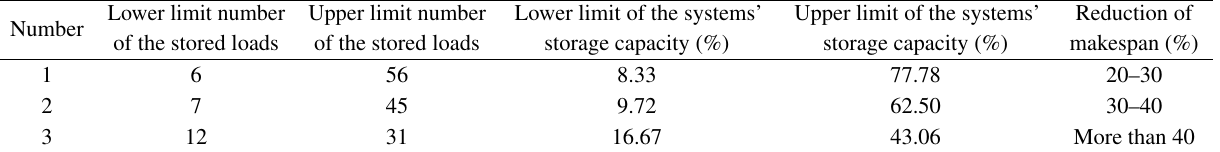
Table 4 Distribution of makespan reduction in the first experiment.